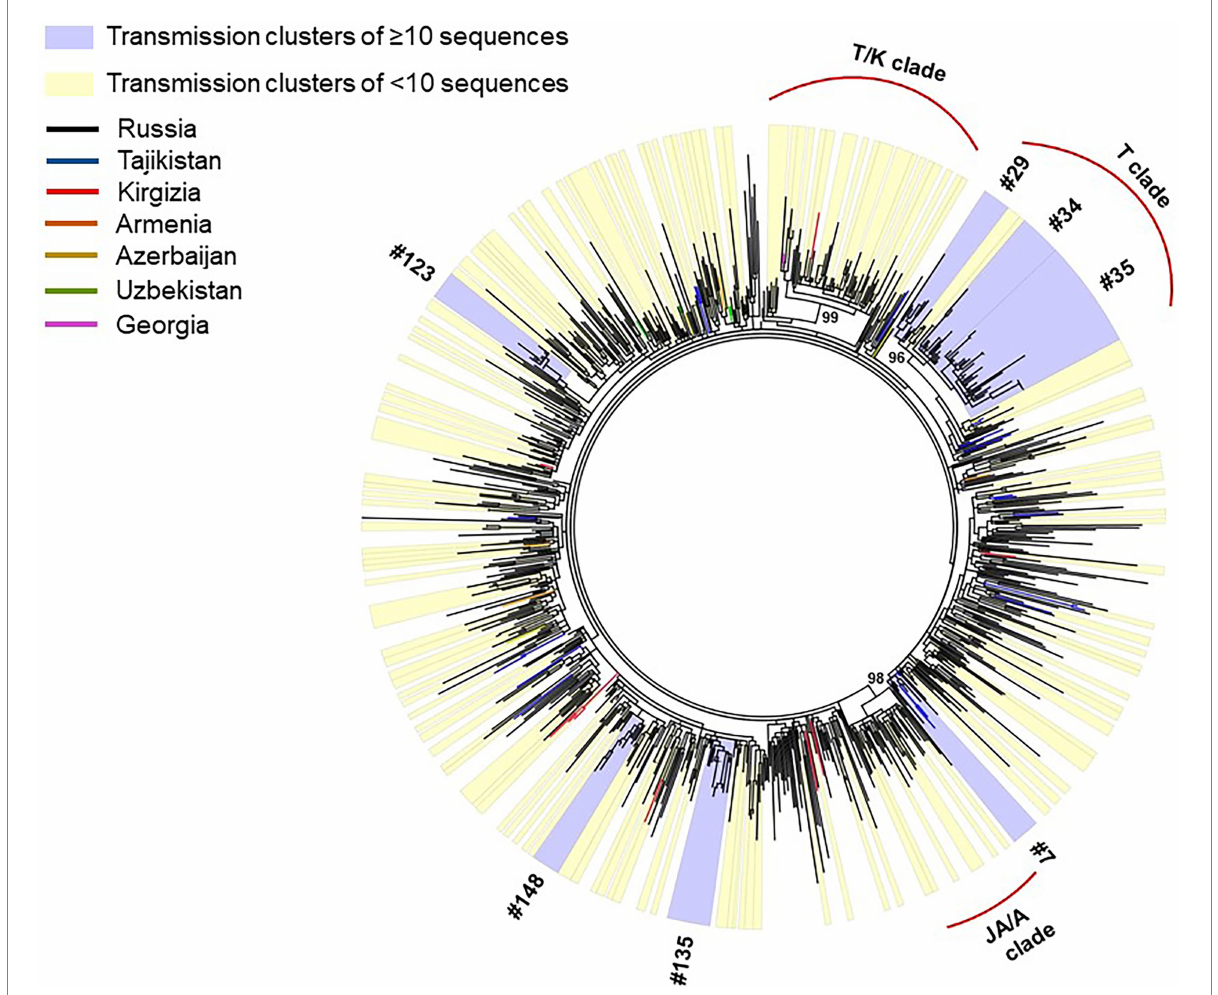
FIGURE 2 IQ-Tree of HIV-1 CRF63_02A 872 pol gene sequences. Tree branches color-codded according to the country of isolation (top left chart). Transmission clusters were identified using Cluster Picker v1.2.3 using a branch support value ≥ 90 and a maximum genetic distance threshold of 0.03. Transmission clusters of ≥ 10 sequences are colored blue; transmission clusters of <10 sequences are colored